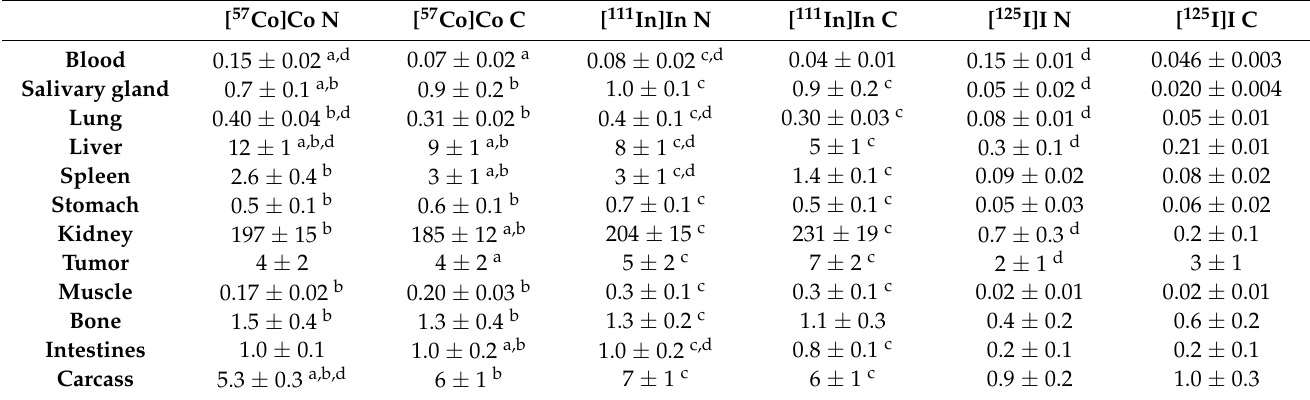
Table 6. Comparative biodistribution of DARPin Ec1 variants labeled with [ 57 Co]Co, [ 111 In]In or [ 125 I]I-HPEM at N - or C -terminus 24 h p.i. in Balb/c nu/nu mice bearing EpCAM-expressing DU145 xenografts. Uptake is presented as % ID/g (average from 4 mice ± SD). Data for intestines with content and carcass are presented as % ID per whole sample. One-way ANOVA with Bonferroni’s multiple comparisons test was performed to find significant differences between Ec1 variants with the same label position ( N - or C